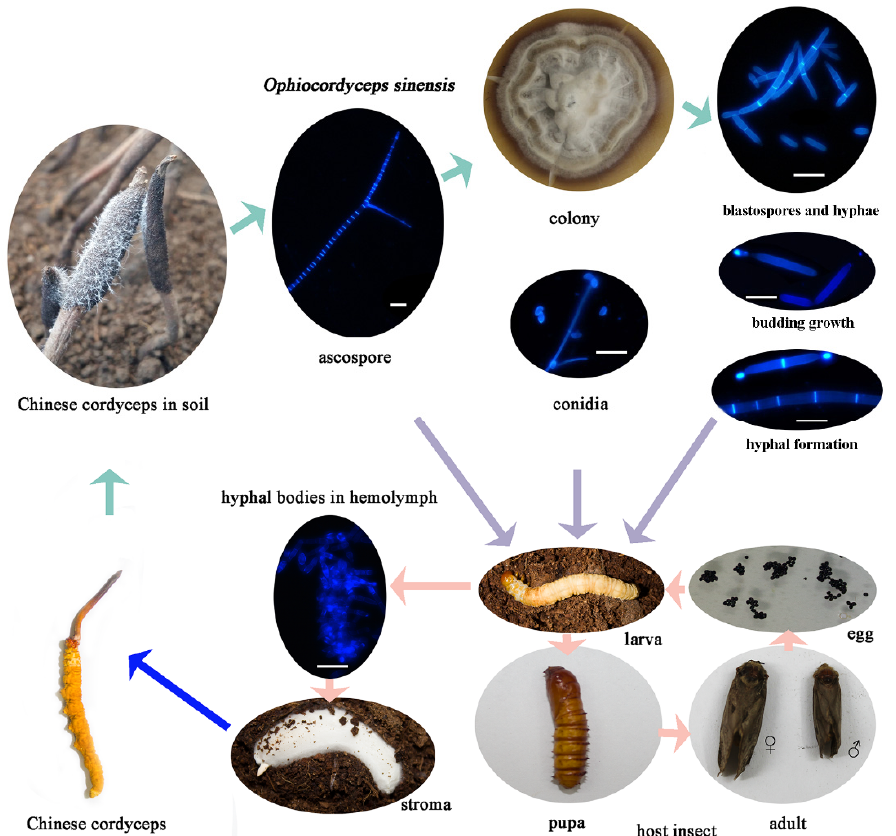
Figure 1. The life cycle of Ophiocordyceps sinensis and the development process of the Chinese cordyceps. The bar indicates 20 µm.